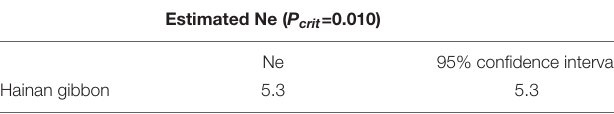
TABLE 6 | Effective population size estimates of Hainan gibbon.